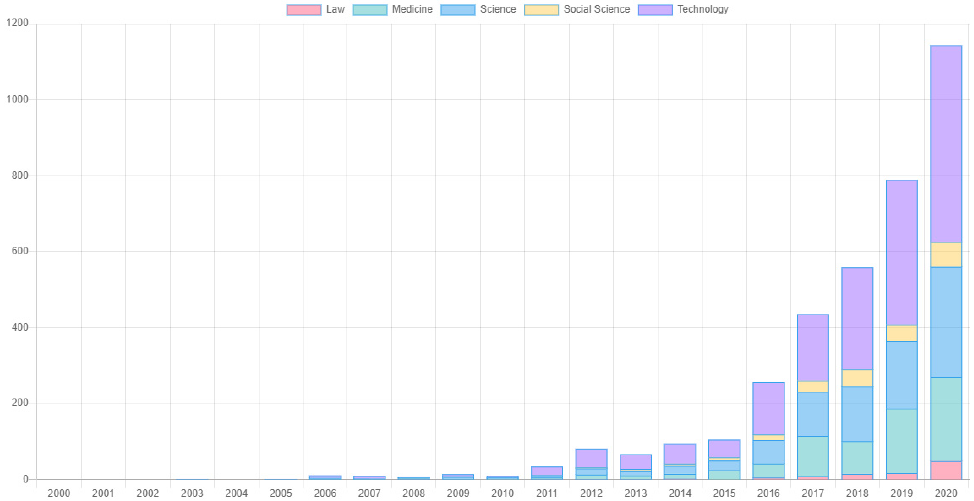
Figure 10. Breakdown of occurrences by domain (progression to actual use).